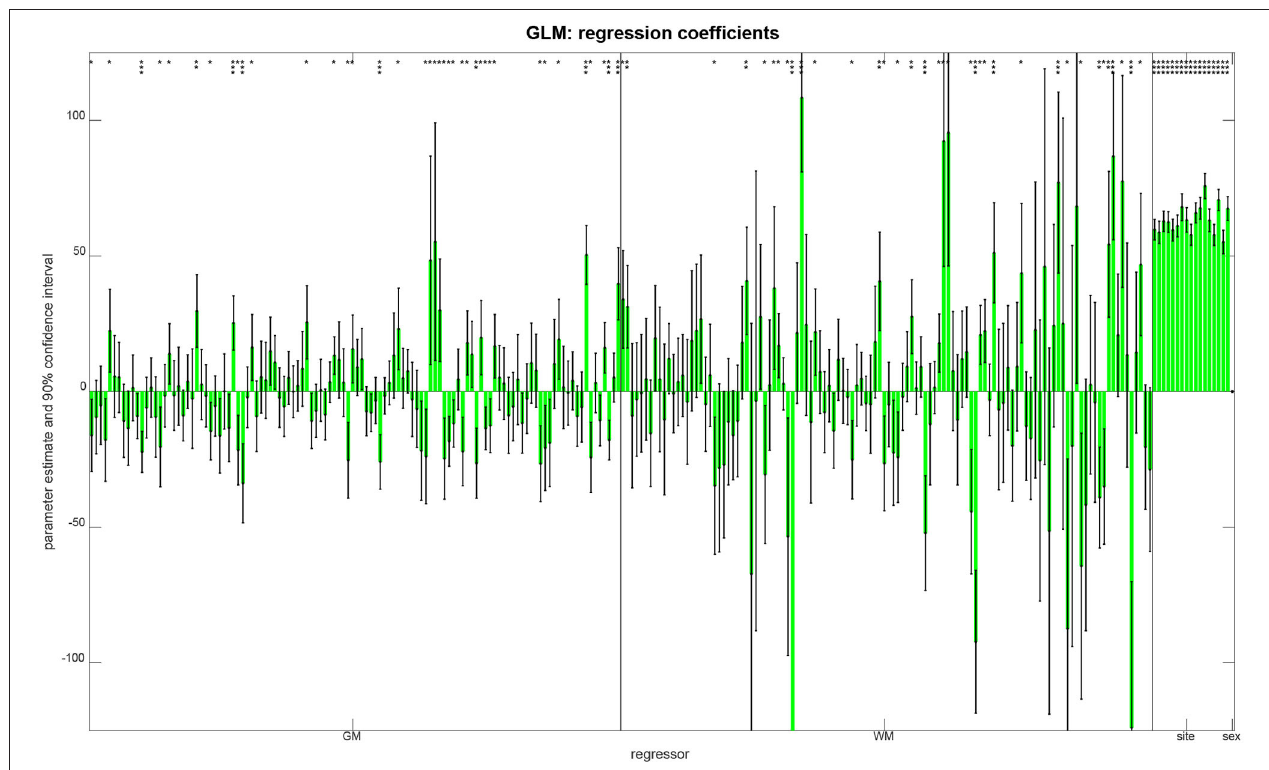
FIGURE 5 | Parameter estimates and confidence intervals from linear regression, obtained when combining training and validation samples into one data set. For each regressor, the estimated coefficient is plotted as a bar and a 90% confidence interval is reported as well. Model parameters are also reported as being significantly different from zero (* p < 0.05; ** p < 0.001; *** p < 0.05 /